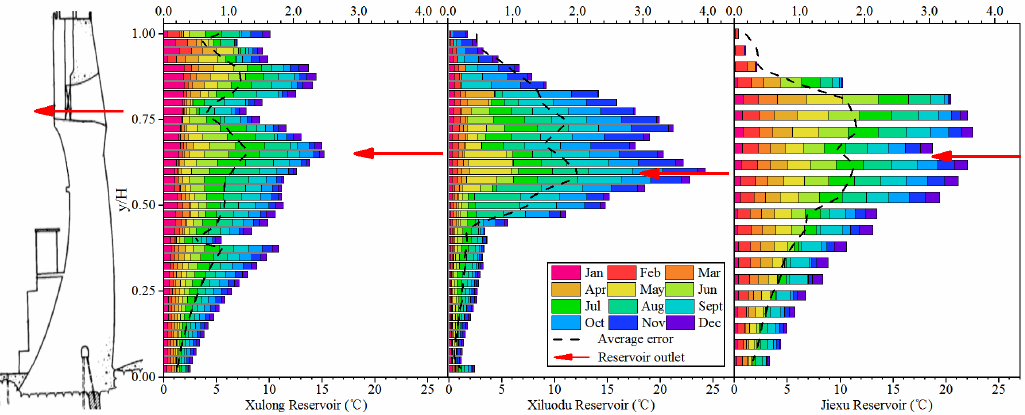
Figure 9. The total error of each depth in the vertical direction of the three reservoirs.